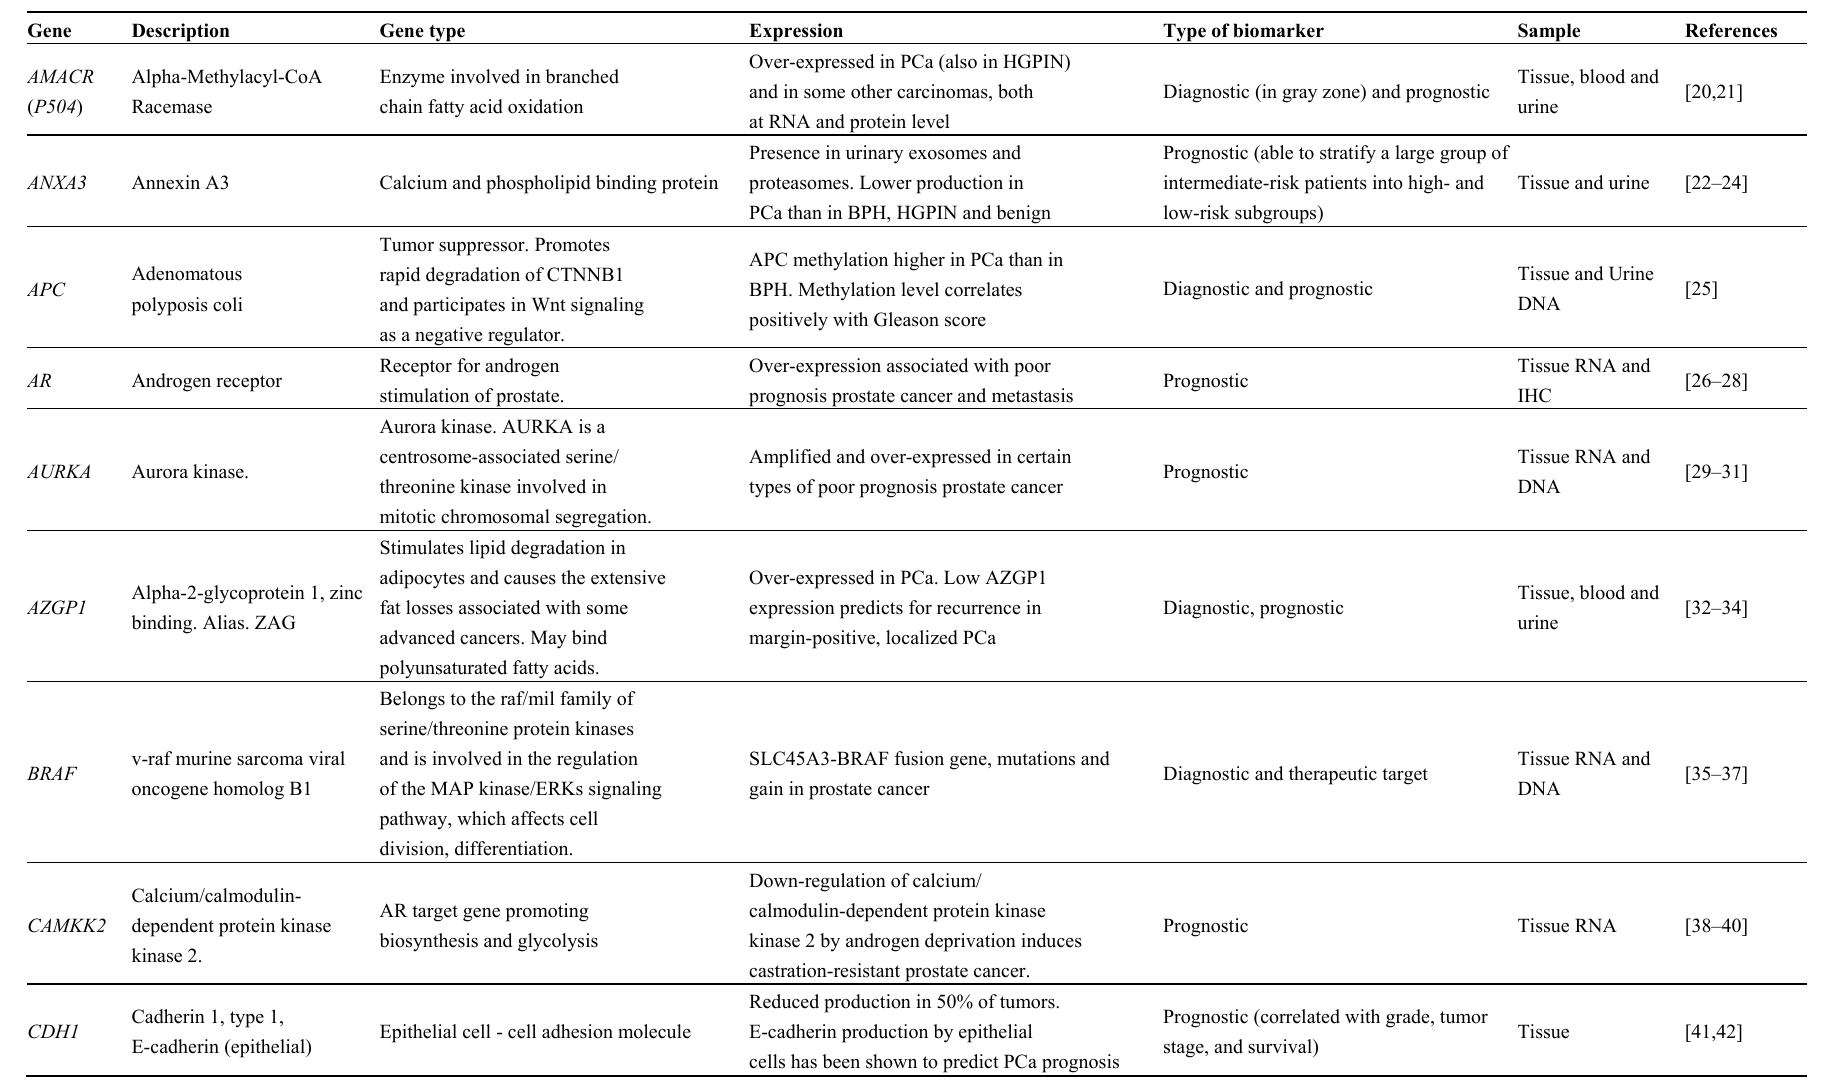
Table 1. Summary of PCa biomarkers in the